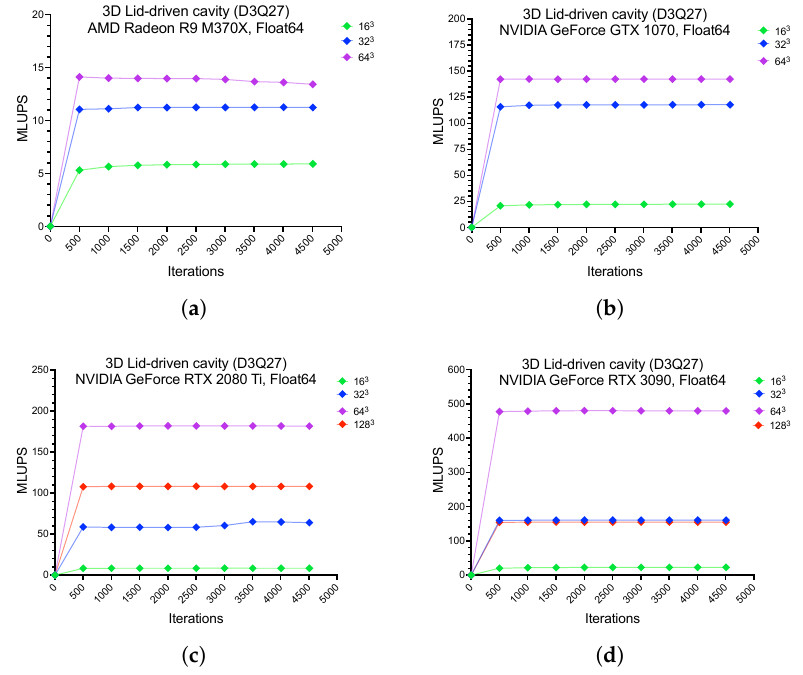
Figure 10. Double-precision performance analysis of 3D lid-driven cavity on D3Q27 stencil with multiple-relaxation time. ( a ) Performance on Radeon R9 M370X GPU; ( b ) Performance on GTX 1070 GPU; ( c ) Performance on RTX 2080 Ti GPU; ( d ) Performance on RTX 3090